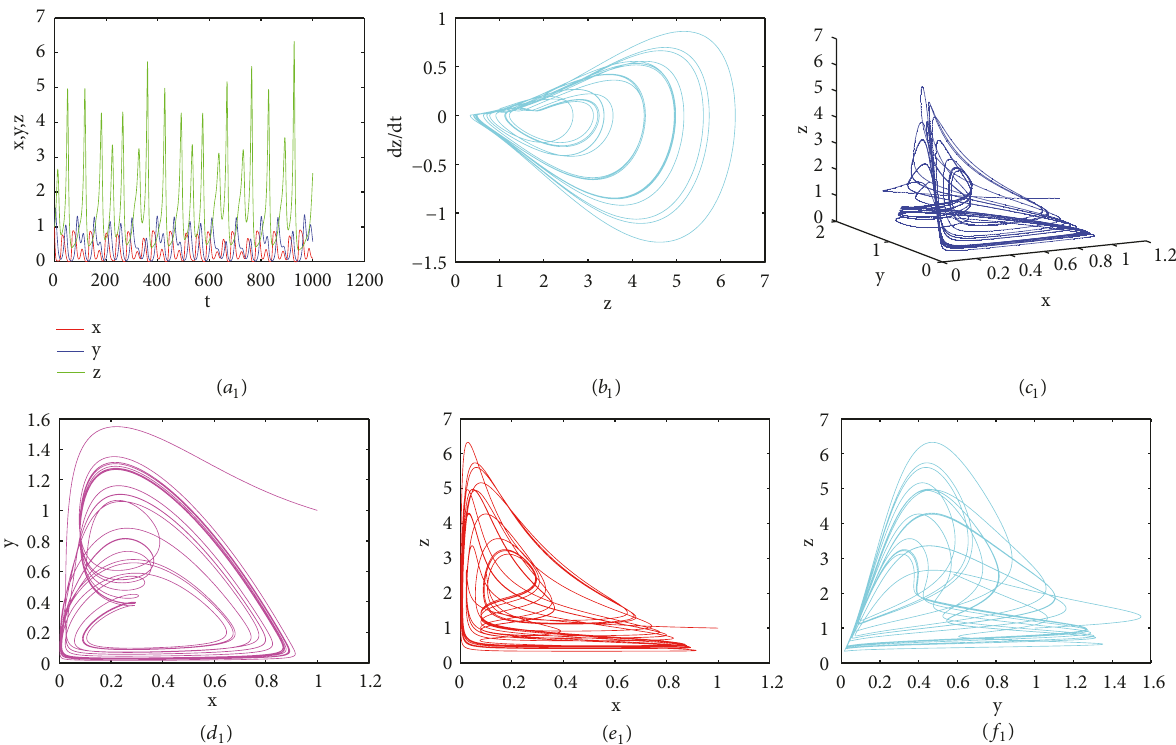
Figure 3: A tritrophic food web system for Experiment 2 with the initial condition (1) : (𝑎 1 ) time series plot of 𝑥,𝑦, 𝑧 ; (𝑏 1 ) phase diagram of 𝑧 ; (𝑐 ) on the three-dimensional space; (𝑑 1